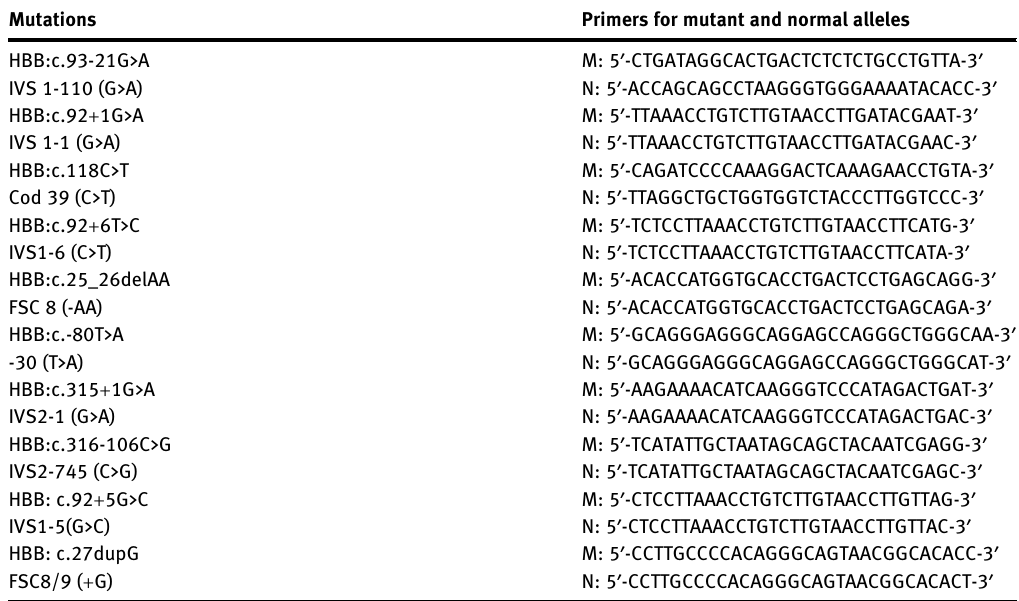
Table  : The sequences of primers used for common beta thalassemia mutations. Mutations Primers for mutant and normal alleles